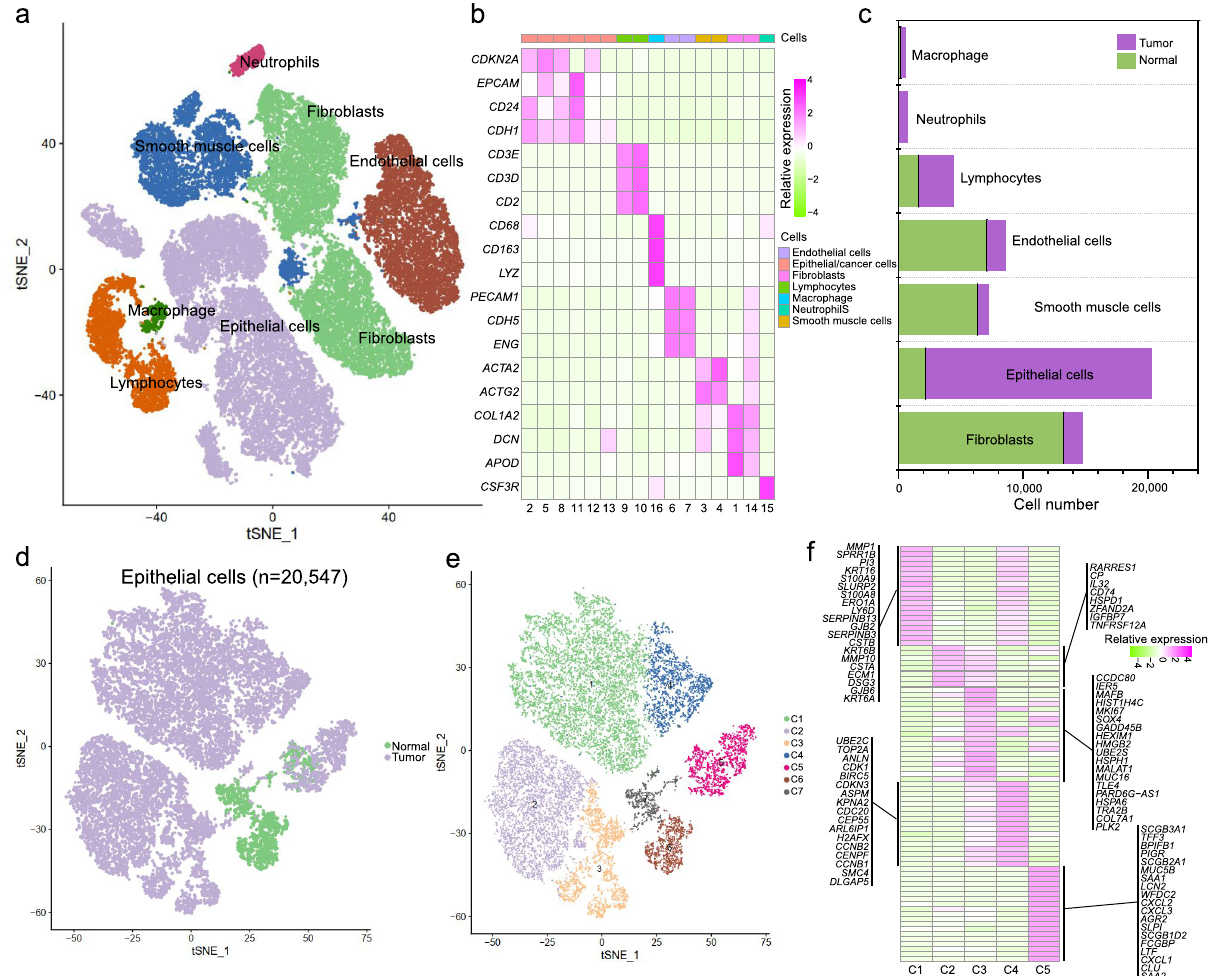
Fig. 1 Tumor heterogeneity of CC at single-cell resolution. a UMAP dimensionality reduction of all cells. b Heatmap shows the relative expression of top marker genes in each cell type. c The cell numbers in CC tumor and NAT samples for each cell type. d UMAP shows epithelial cells in CC tumor and NAT samples. e UMAP shows seven different clusters of epithelial cells. f Heatmap shows the top marker genes in each epithelial